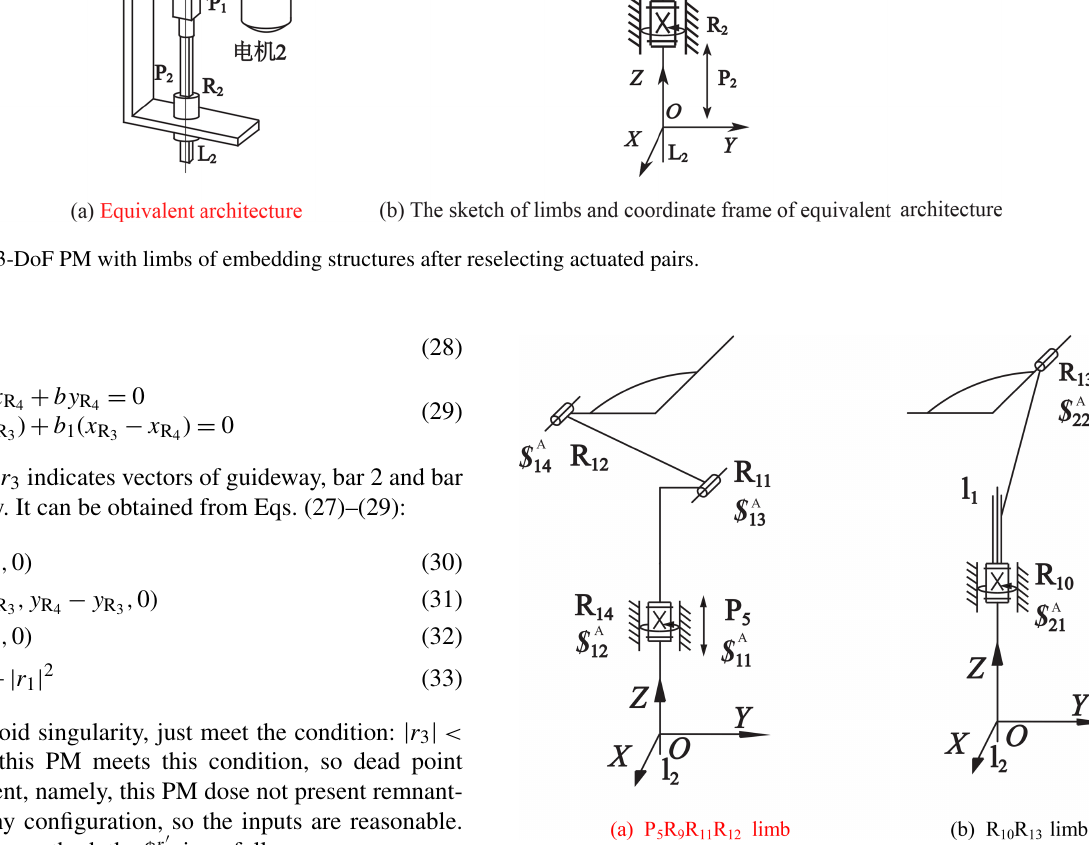
Figure 6. The coordinate system of 2-DoF PM with limbs of em- bedding